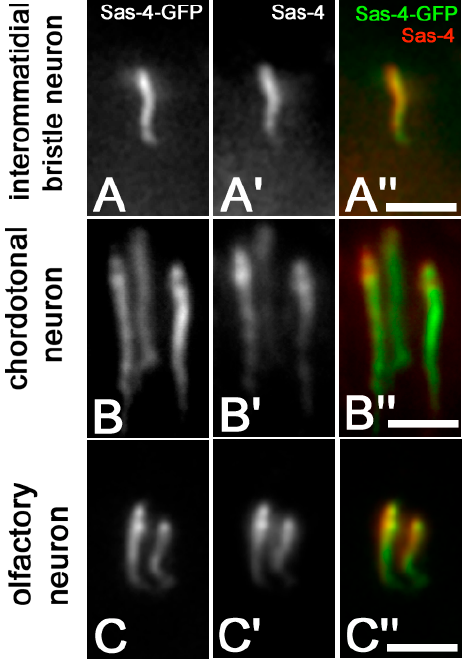
Figure 5. Colocalization of Sas-4-GFP signal and anti-Sas-4 stain in the interommatidial bristle ( A – A ″ ), chordotonal ( B – B ″ ) and olfactory ( C – C ″ ) neurons from pupae of 45 h APF. Scale bars: 15 µm.